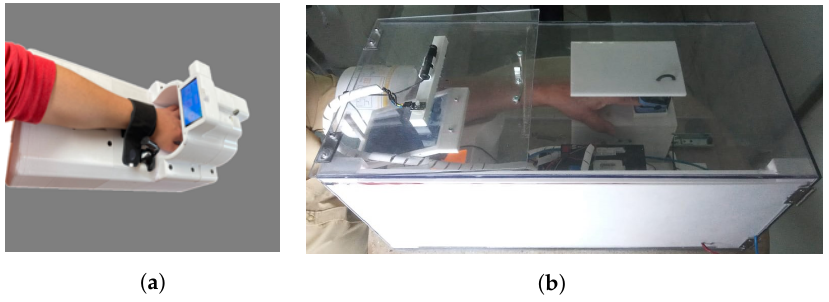
Figure 1. Two versions of the IPMA used in this study. ( a ) Version A. ( b ) Version B. Table 1. Features of each version of the